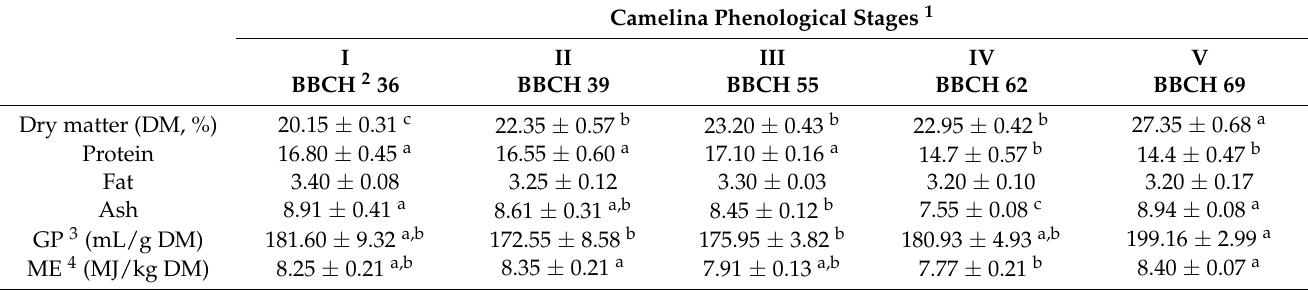
Table 4. Chemical composition and nutritive value of Camelina harvested during different phenolog- ical stages (mean ± standard